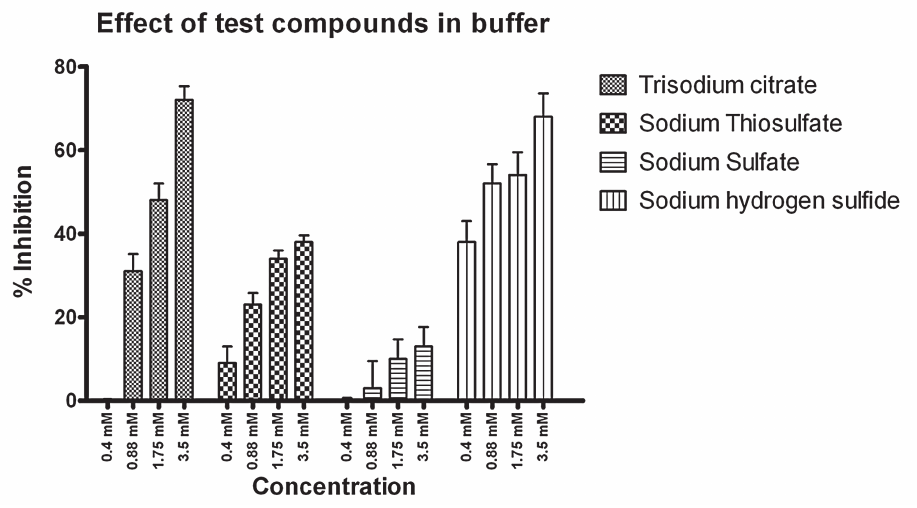
Figure 3 - Effect of test compounds on kinetics of calcium oxalate in buffer. Data are mean±S.D. of three observations. (P<0.001).